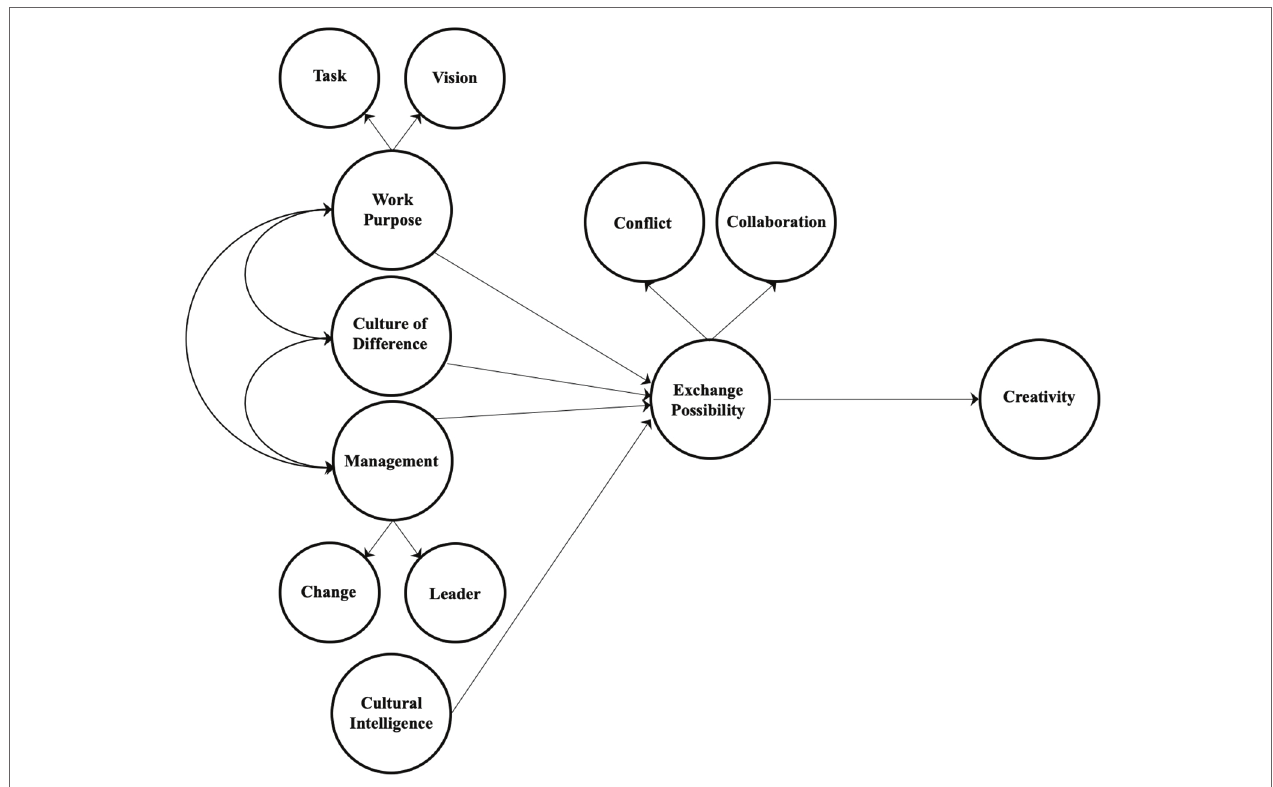
FIGURE 1 | Living and working together model to explain